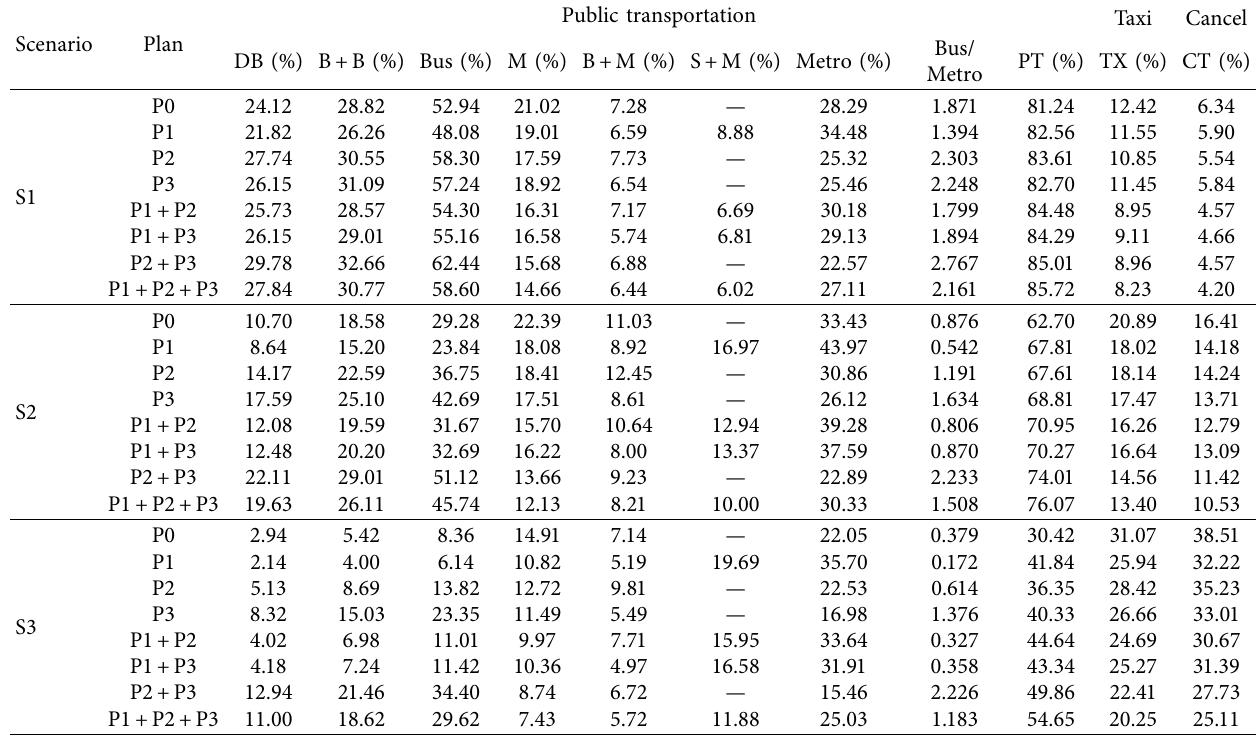
Table 7: Simulation results in different